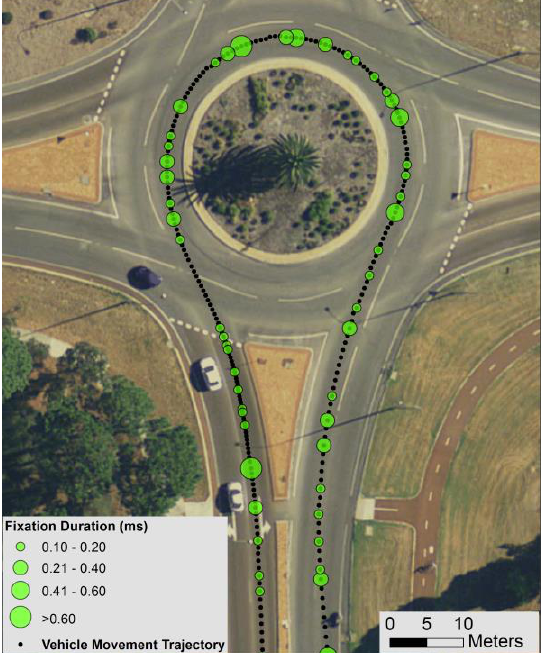
Figure 4. The spatial distribution of eye fixation behaviour at right-turn from driver A